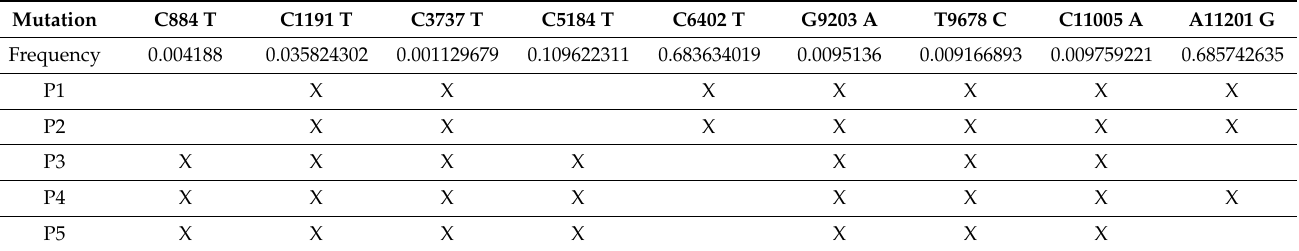
Table 3. Case-A ORF1a Mutations and Frequencies.